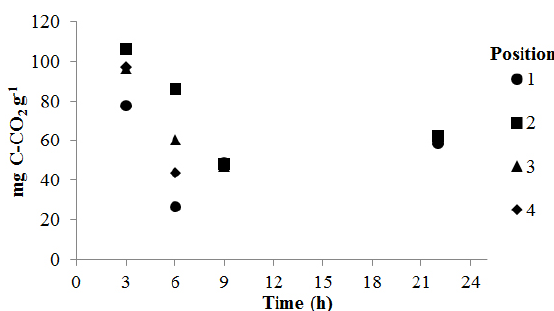
Figure 5 - Evolution of substrate-induced respiration from different hillslope positions in the Bocaina Mountain Range, in Lavras – Minas Gerais, Brazil. 1 - upper backslope; 2 - middle backslope; 3 - lower backslope; 4 -